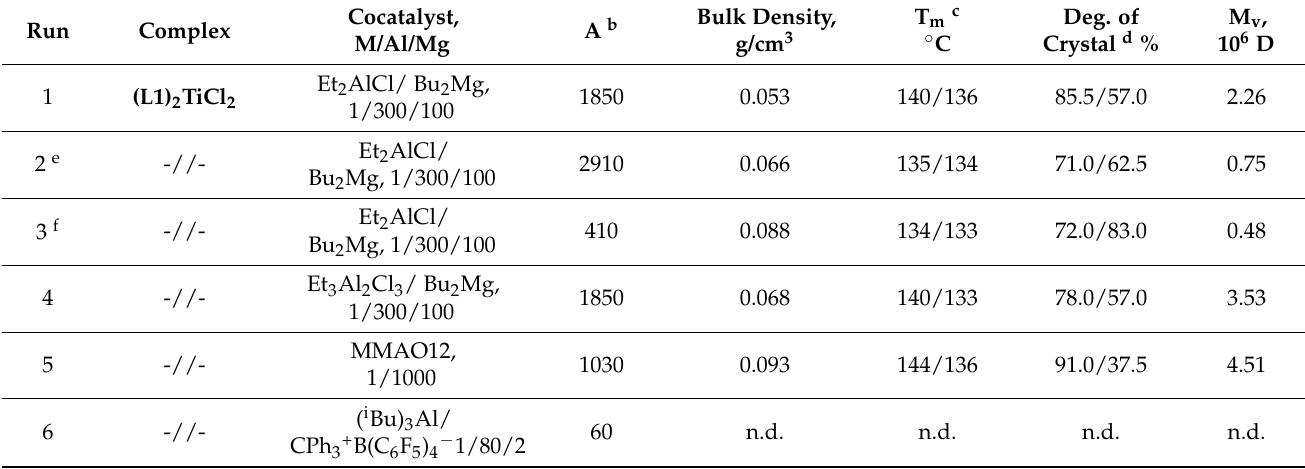
Table 1. Ethylene Polymerization by Ti(IV) and Zr(IV) phenoxy-imine complexes a .